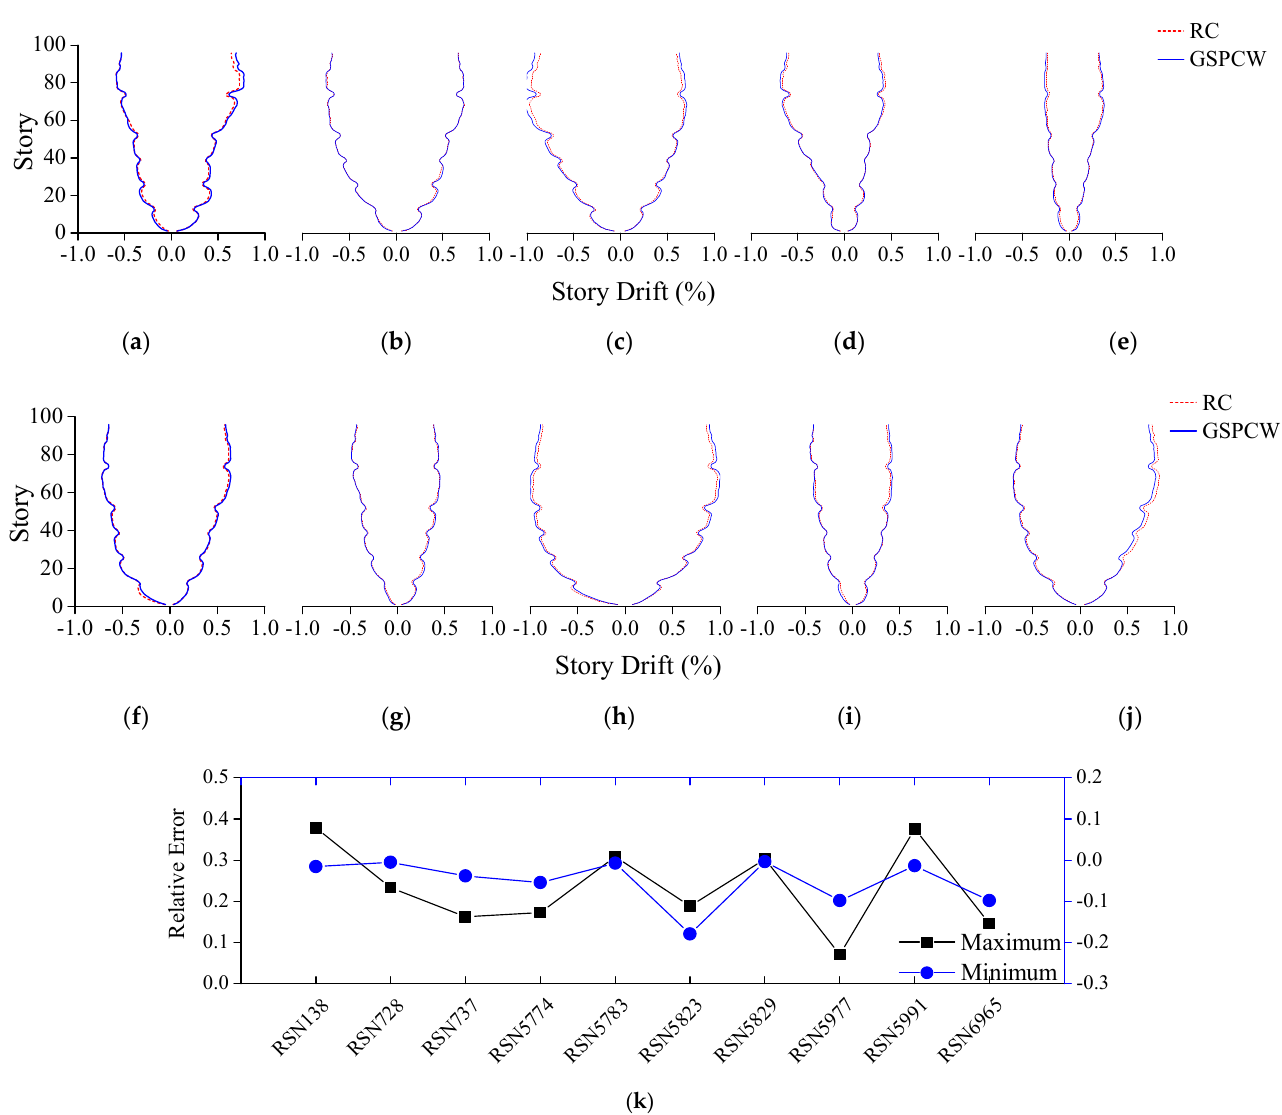
Figure 17. Comparison of story drift ratios of each ground motion between RC and GSPCW models: ( a ) RSN138; ( b ) RSN728; ( c ) RSN737; ( d ) RSN5774; ( e ) RSN5783; ( f ) RSN5823; ( g ) RSN5829; ( h ) RSN5977; ( i ) RSN5991; ( j ) RSN6965; ( k ) Relative error.